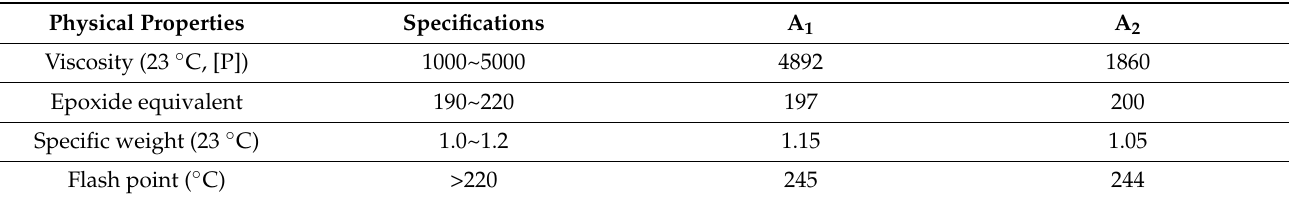
Table 2. Epoxy resin A component test results.